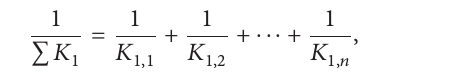
Figure 8: The comparison of frequency response curves for varying cubic stiffness